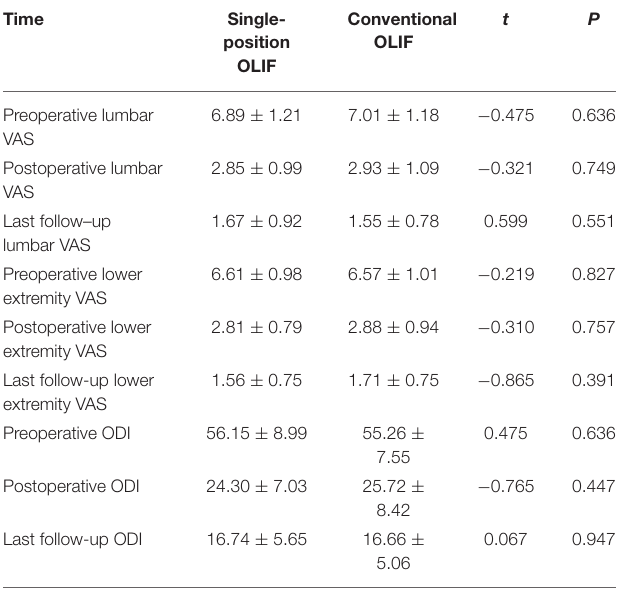
TABLE 2 | Comparison of the lumbar VAS score and lower limb VAS score between the two groups preoperatively, postoperatively and at the last follow-up.